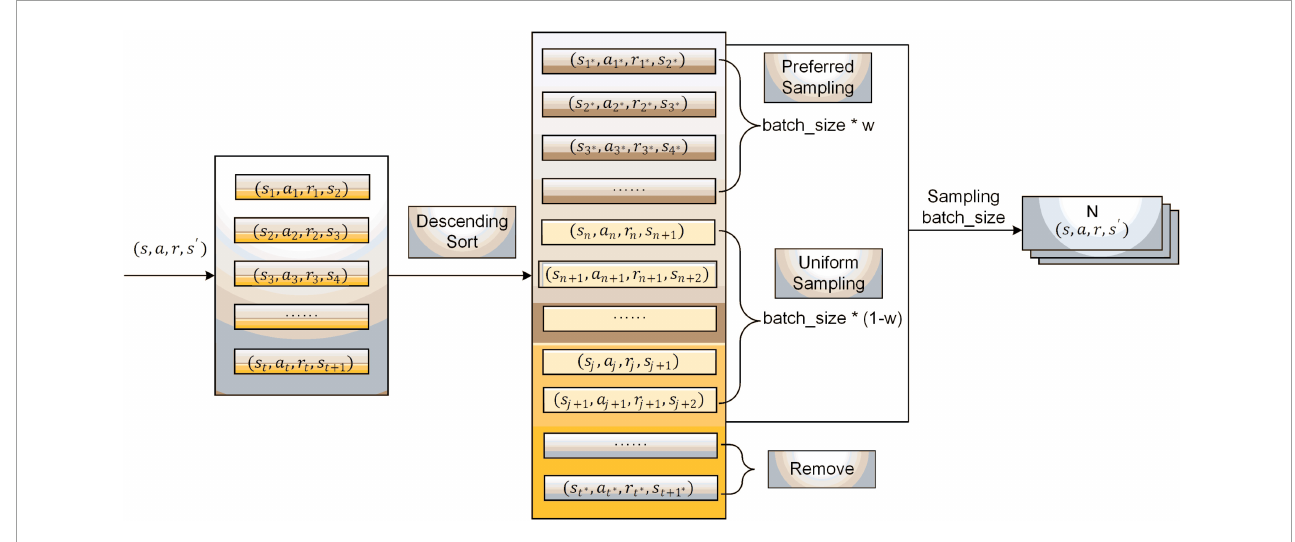
FIGURE4 Experience pool data processing and